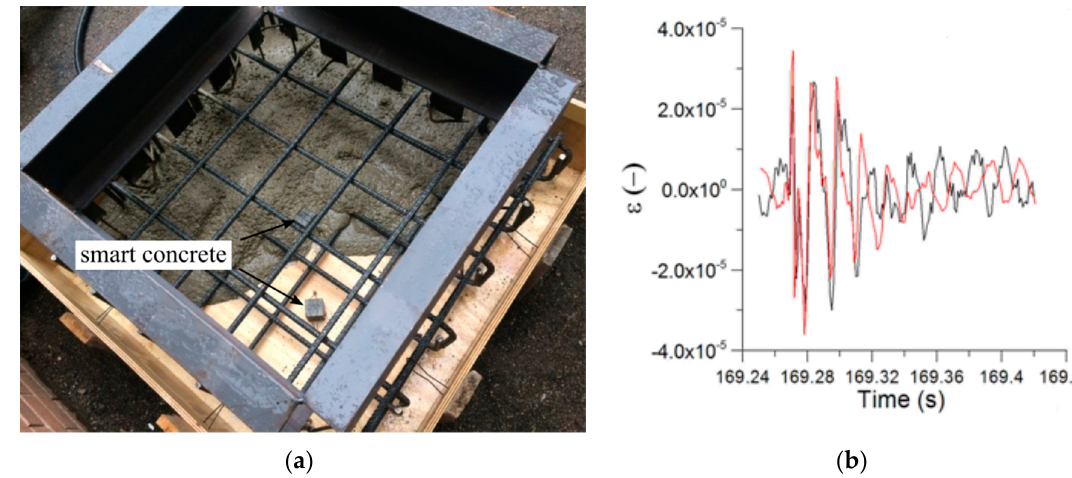
Figure 4. Example application of smart concrete sensors embedded to measure strain in reinforced concrete structures: ( a ) Photo evidence of the embedded sensor during concrete casting; ( b ) Comparison of the output of the smart concrete sensor (black line) and of a traditional strain gauge (red line) during a hammer hit test on a RC beam.